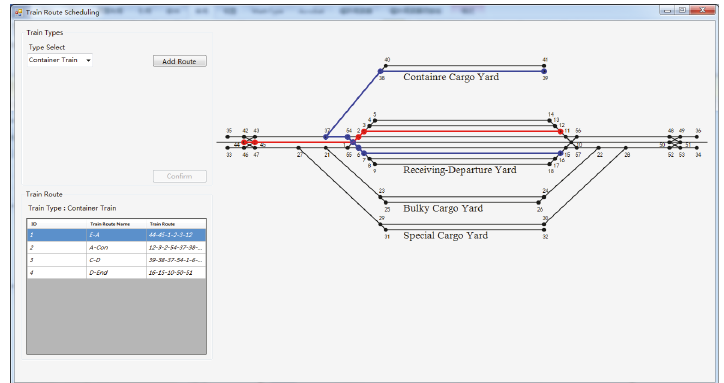
Figure 9: Interface of train route